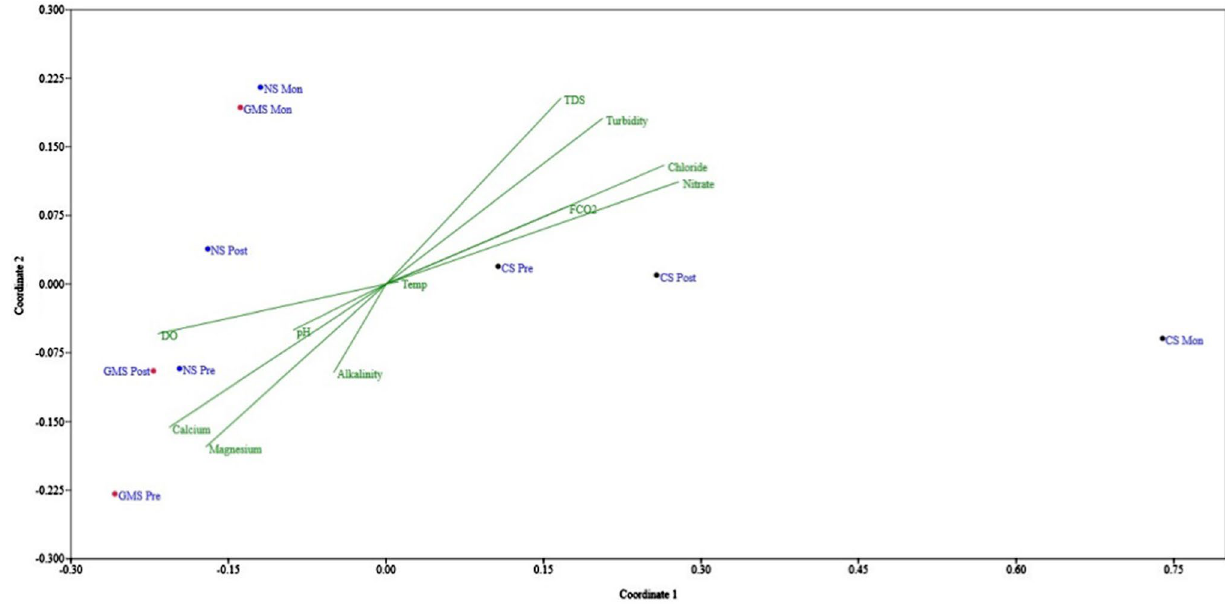
Fig. 5 Non-metric multidimensional scaling (MDS) plot of prawn species abundance and physicochemical properties at different sites and sea- sons Table 3 Karl Pearson correlation coefficient between physicochemical parameters and prawn abundance